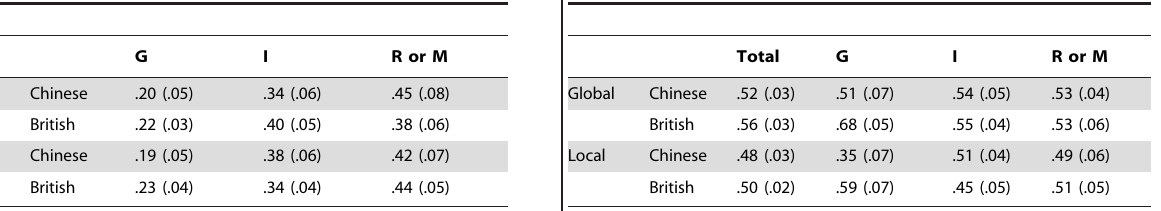
Table 2. Mean Values of A 9 for Each Attribution of Each Group in the Classification Test for Irrelevant